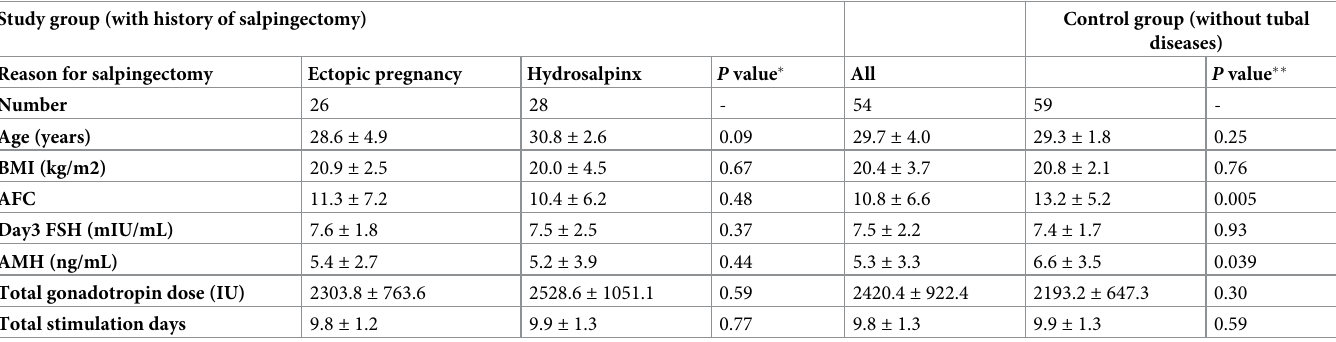
Table 1. Basic characteristics of all enrolled patients at the time of recruitment. Study group (with history of salpingectomy) Control group (without tubal